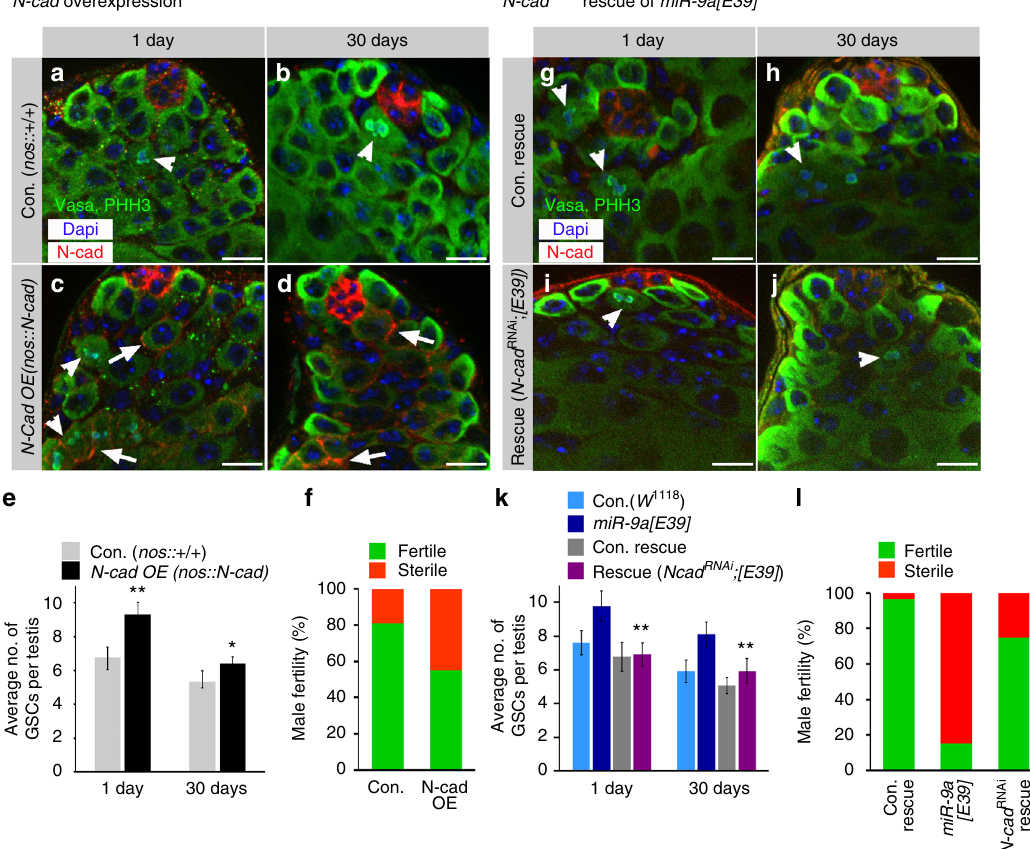
Fig. 5 N-cad overexpression mimics miR-9a[E39] phenotype and N-cad RNAi rescues miR-9a[E39] mutants. a – f Overexpression of N-cad in GSCs and progenitor germ cells ( N-cad OE : nos-GAL4 , UAS-N-cad ) increases GSCs number but reduces their division frequency compared to control (Con.: nos-GAL4 outcrossed to w 1118 ). g – l N-cad RNAi in GSCs and progenitor germ cells of miR-9a[E39] mutants rescue mutant phenotype (rescue: nos-GAL4 , UAS-N-cad RNAi ; miR-9a[E39] , Con. rescue: nos-GAL4 , UAS-N-cad RNAi ; miR-9a[E39] /TM6). a – d , g – j Representative images of testes immunostained for N-cad ( red ), Vasa and pHH3 ( green ) and DAPI ( blue ; scale bars 10 µ m). Arrowheads denote mitotic germ cells and arrows denote N-cad ectopic expression ( c – d ). e , k Shown are average number of GSCs per testis along with 95% con fi dence interval ( error bars ). Statistical signi fi cance was determined as in Fig. 1d. e The total number of testes scored: Con. 1-day ( n = 28) 30-days ( n = 41); N-cad OE 1 -day ( n = 35), 30-days ( n = 41). P < 0.005 between N-cad OE and control in 1- day and P < 0.01 in 30-days. k The total number of testes scored: Con. ( w 1118 ) 1-day ( n = 23), 30-days ( n = 35); miR-9a[E39] 1-day ( n = 27), 30-days ( n = 40). Con. rescue 1-day ( n = 27), 30 days ( n = 29) ; miR-9a rescue 1-day ( n = 30), 30-days ( n = 31). P < 0.005 between N-cad RNAi miR-9a[E39] rescue and miR-9a[E39] in young and aged males. f , l Fertility assay of aged males. f Con. ( n = 21) and N-cad OE ( n = 21). Note decreased fertility of aged N-cad overexpression. l Con. rescue ( n = 29), miR-9a[E39] ( n = 21), and N-cad RNAi miR-9a[E39] rescue ( n = 24).Note that N-cad RNAi rescues miR-9a[E39]